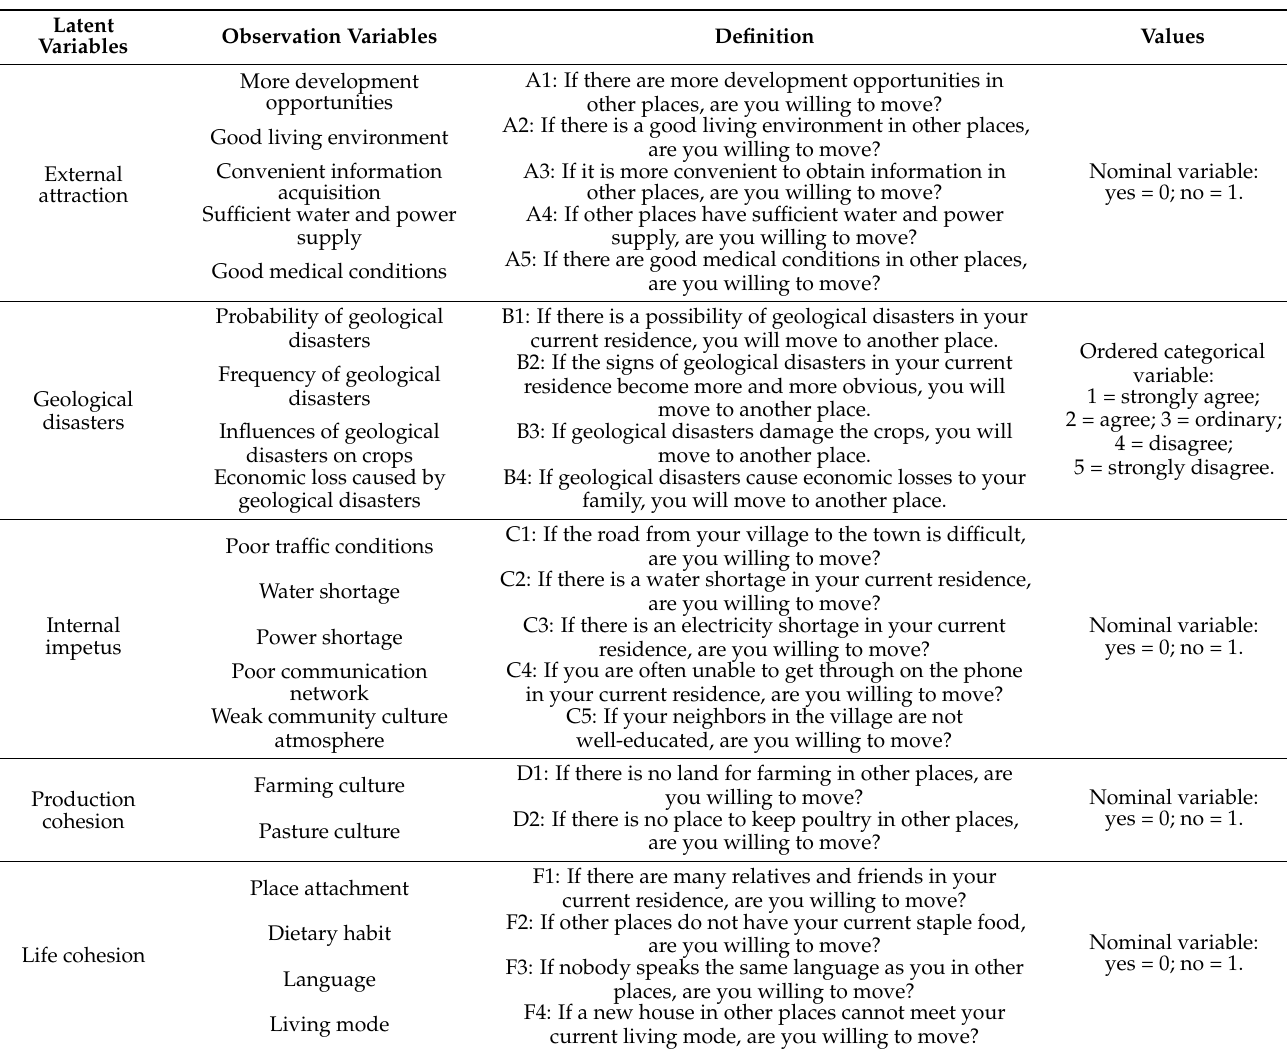
Table 1. Driving forces affecting the reconstruction willingness of peasant